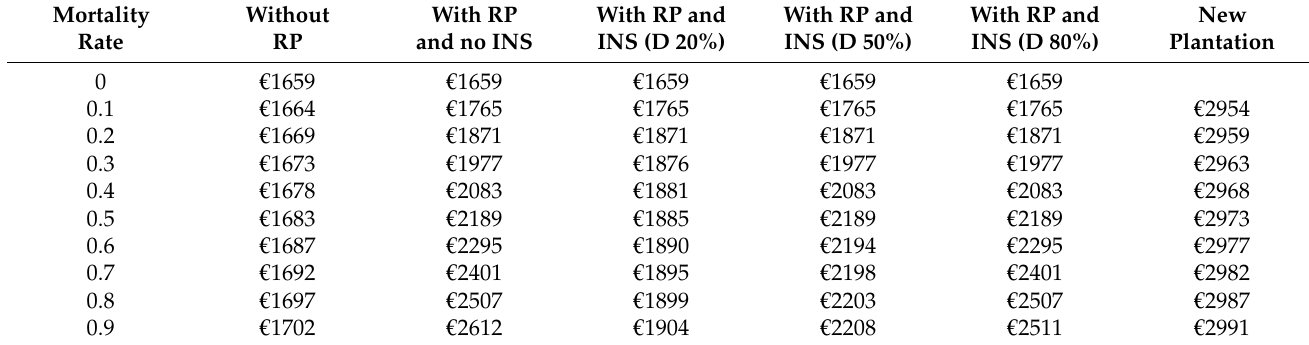
Table 5. Total discounted costs borne by the forest owner in EUR/ha for maritime pine (